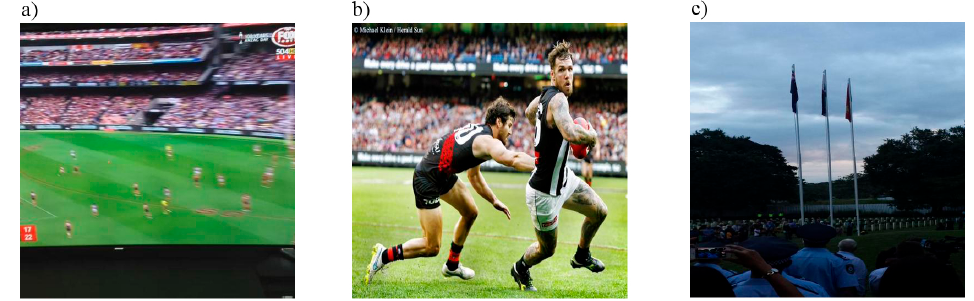
Figure 14. Example of false positive images for the training dataset ADon ( a ) screen relaying the broadcast [73] ( b ) a media image [74] and ( c ) a place of indeterminate location [75]. These versions of